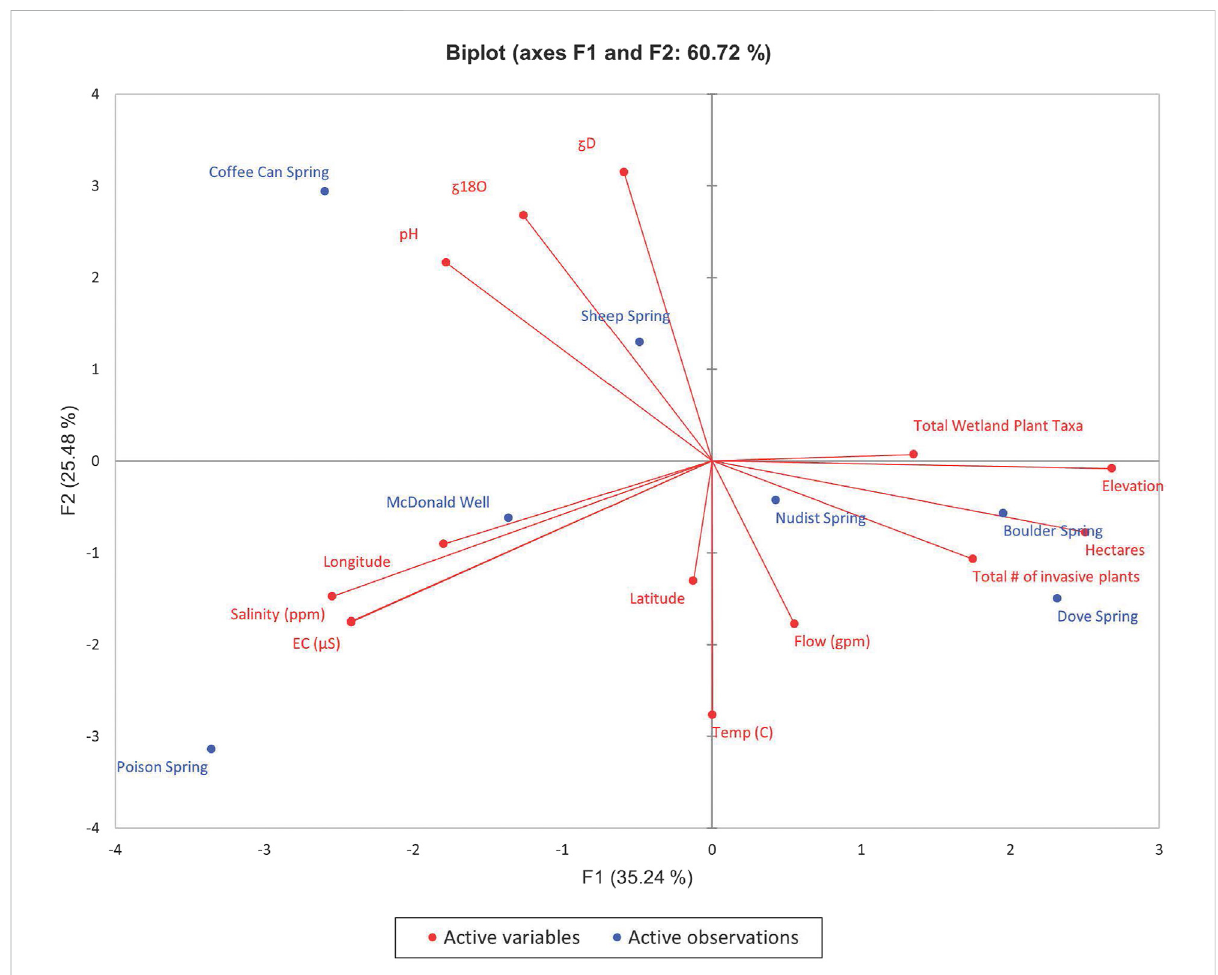
FIGURE 6 PCA biplot of F1 and F2 for ecohydrological dataset for the Western Desert